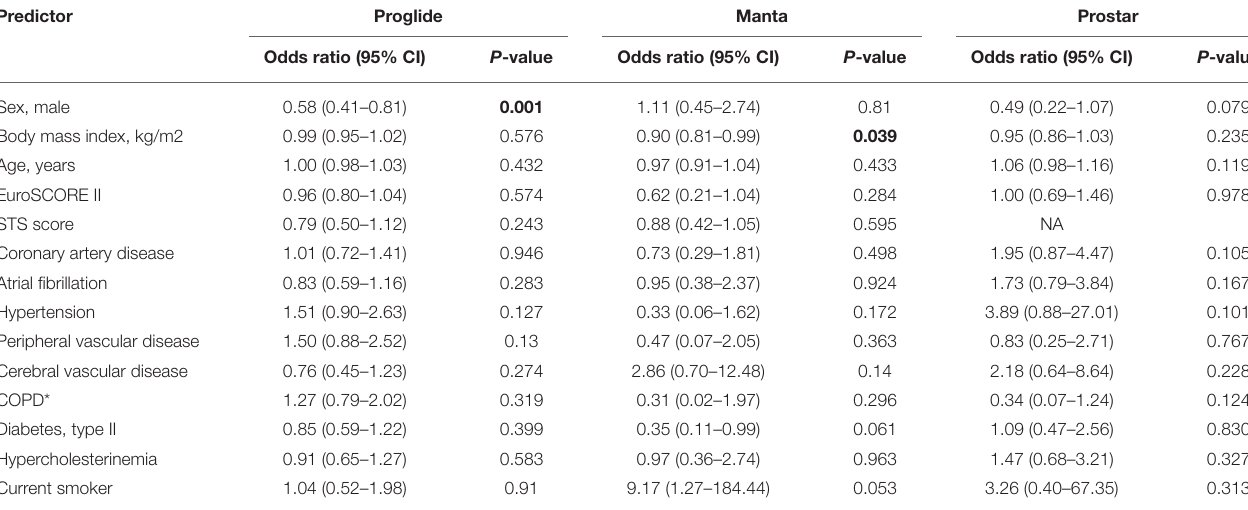
TABLE 4 | Results of univariable logistic regression assessing the risk factors for any vascular complication (major and minor combined) in each VCD subgroup separately. Predictor Proglide